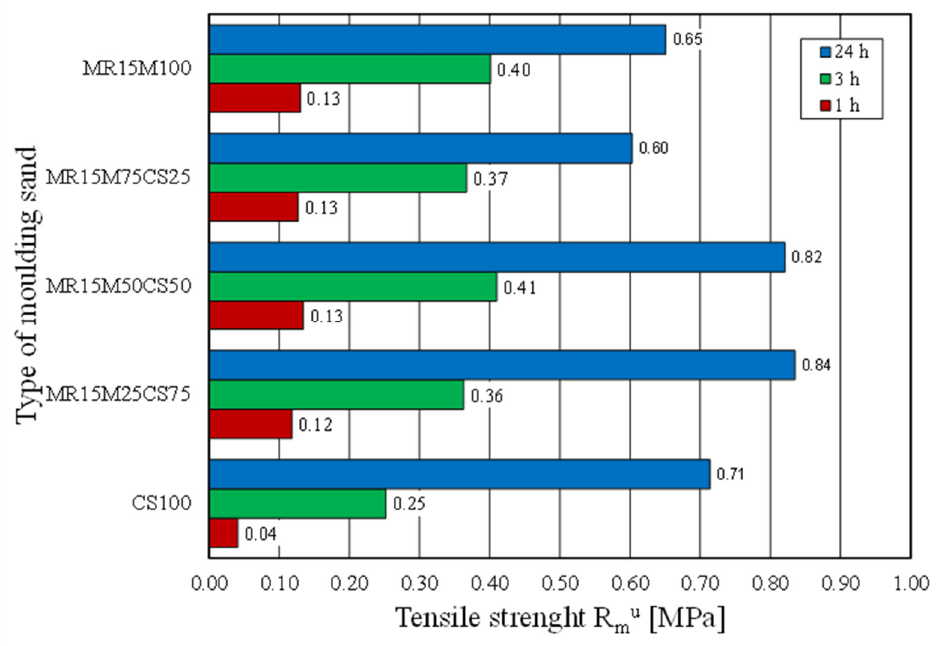
Figure 22. Tensile strength R mu of tested moulding sands.